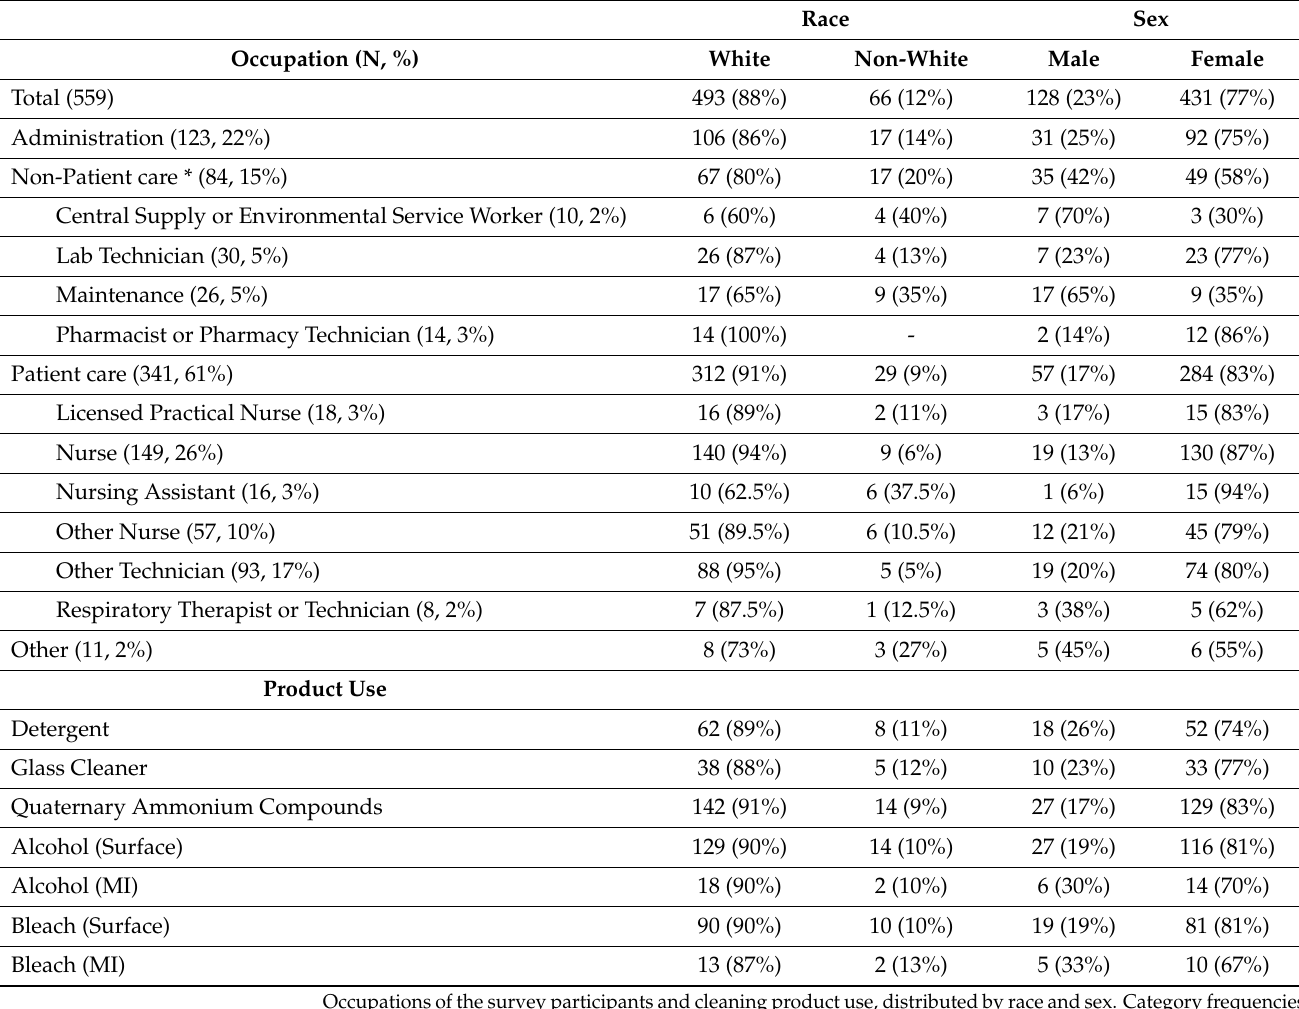
Table 2. Distribution of occupation and cleaning products used by race and sex, N